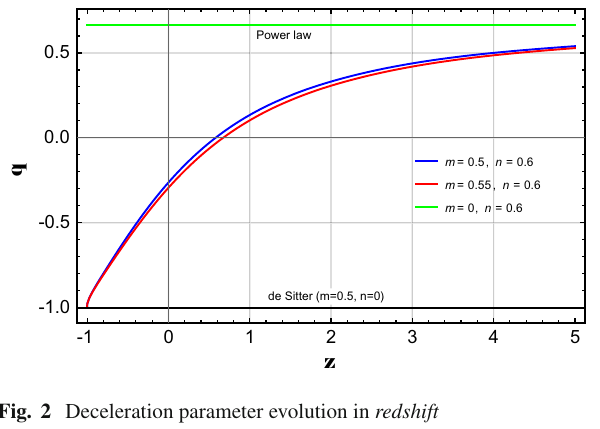
Fig. 2 Deceleration parameter evolution in